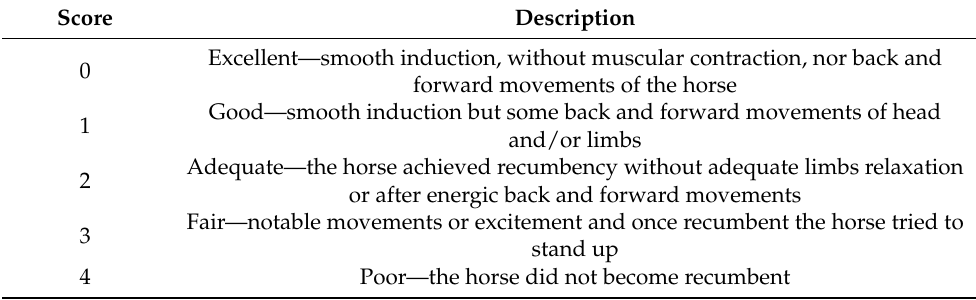
Table 2. Scoring system for the quality of